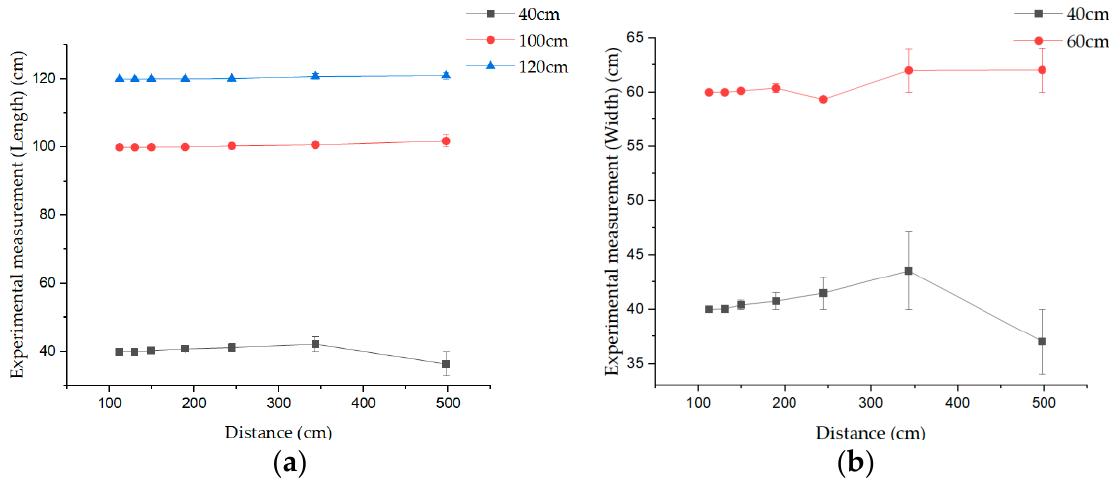
Figure 18. Verify the data error bar. ( a ) Verify the length data error bar; ( b ) verify the width data error bar. Table 4. Length and width error analysis table.